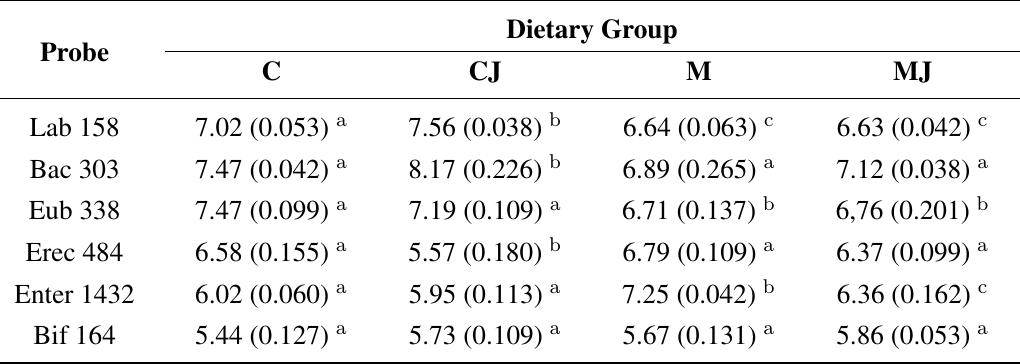
Table 3. The microorganisms which are able to adhere to the intestinal epithelium of rats